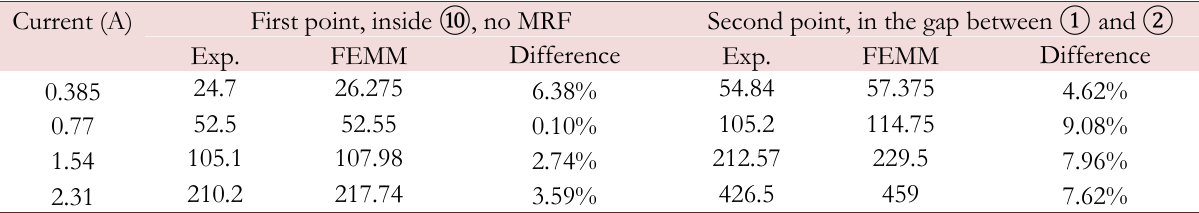
Table 2: Experimental and FEMM values of the induction magnetic field